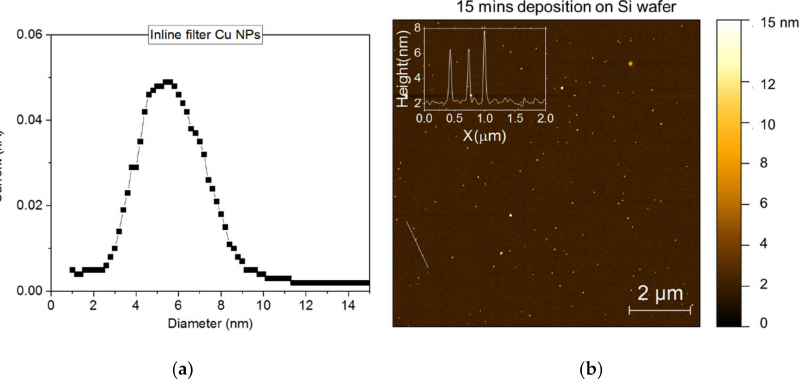
Figure 3. ( a ) MesoQ filter grid detection current versus nanoparticle diameter and ( b ) AFM 10 × 10 microns scan of a Si wafer piece deposited with Cu NPs (15 min) along with the CC samples. The inset graph shows the line height profile of the white line located on the lower left side of the AFM scan, dissecting 3 NPs.